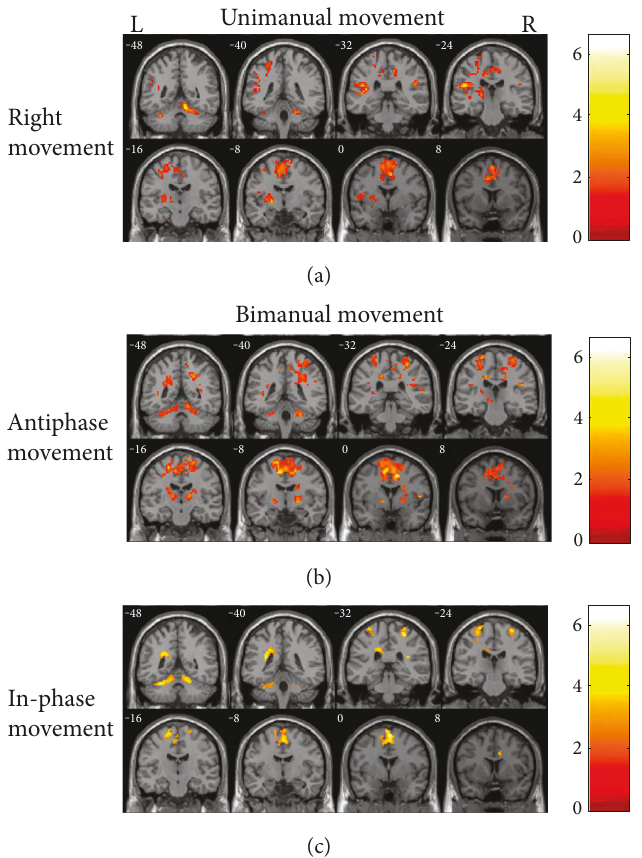
Figure 1: Brain regions activated during performing unimanual (right elbow) and bimanual (antiphase and in-phase) movements in the normal subject group. Results were thresholded at p < 0 0001 , noncorrected and cluster size > 10. (a) Brain areas activated during performing unimanual movement (right elbow). (b) Brain areas activated during performing antiphase bimanual movements. (c) Brain areas activated during performing in-phase bimanual